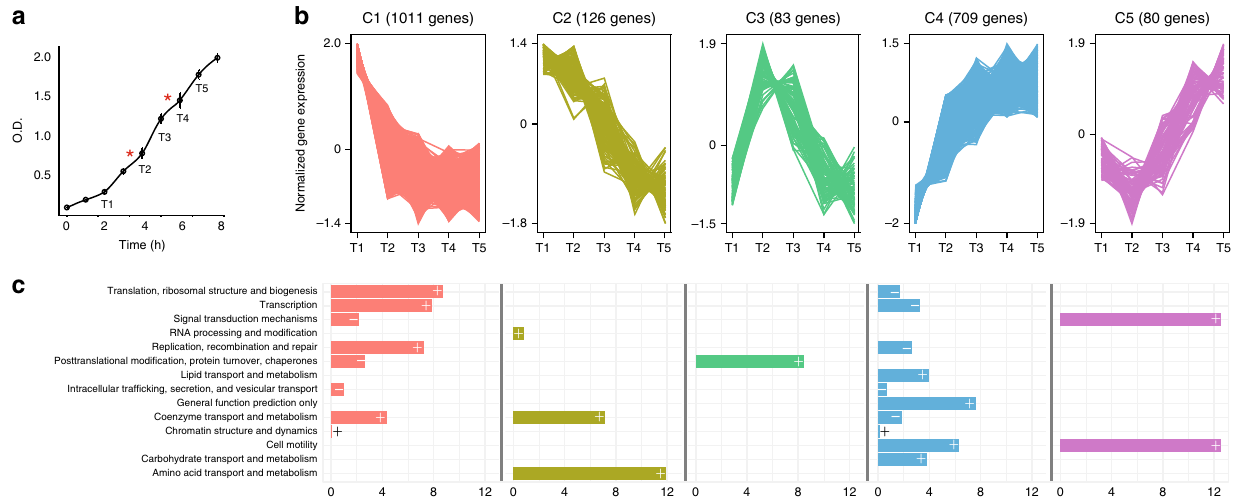
Fig. 1 Transcriptomic data of the multi-auxic growth. a PhTAC125 growth curves in peptone. Asterisks represent hypothetical switch points and T1 – T5 indicate the sampled time points. b Clustering of PhTAC125 genes according to their expression values (normalized according to clust algorithm, see “ Methods ” ) throughout the growth curve. c COG functional categories that are signi fi cantly over- ( “ + ” sign) or under- ( “ − ” sign) represented inside each cluster. Source data are provided as a Source Data fi